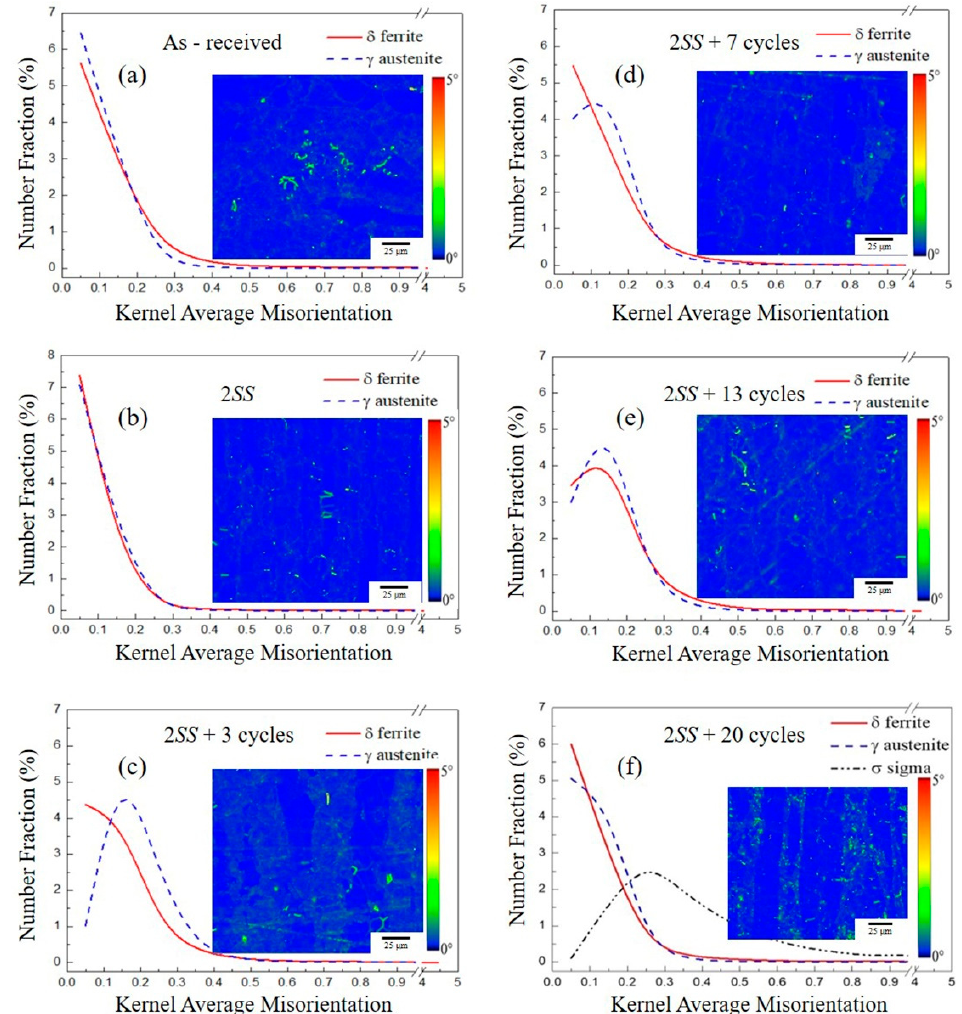
Figure 7. Kernel average misorientation (KAM) for different thermal cycles at ( a ) as-received; ( b ) 2SS; ( c ) 2SS + 3 cycles; ( d ) 2SS + 7 cycles; ( e ) 2SS + 13 cycles; ( f ) 2SS + 20 cycles.